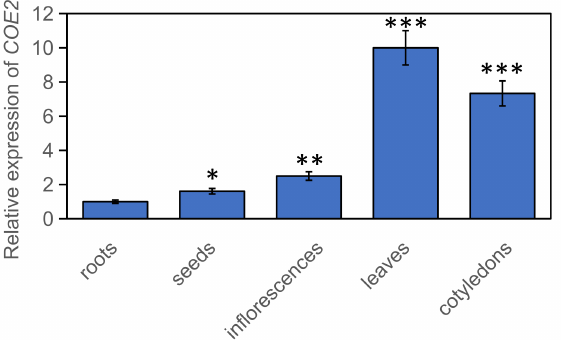
Figure 3. Expression patterns of COE2 in different tissues of seedlings. The samples of cotyledons, roots, mature leaves, inflorescence, and seeds were harvested and used to examine the expression of COE2 by qPCR. Three biological replicates were used. The student’s t -test of other tissues versus roots, * p < 0.05%, ** p < 0.01%, *** p <